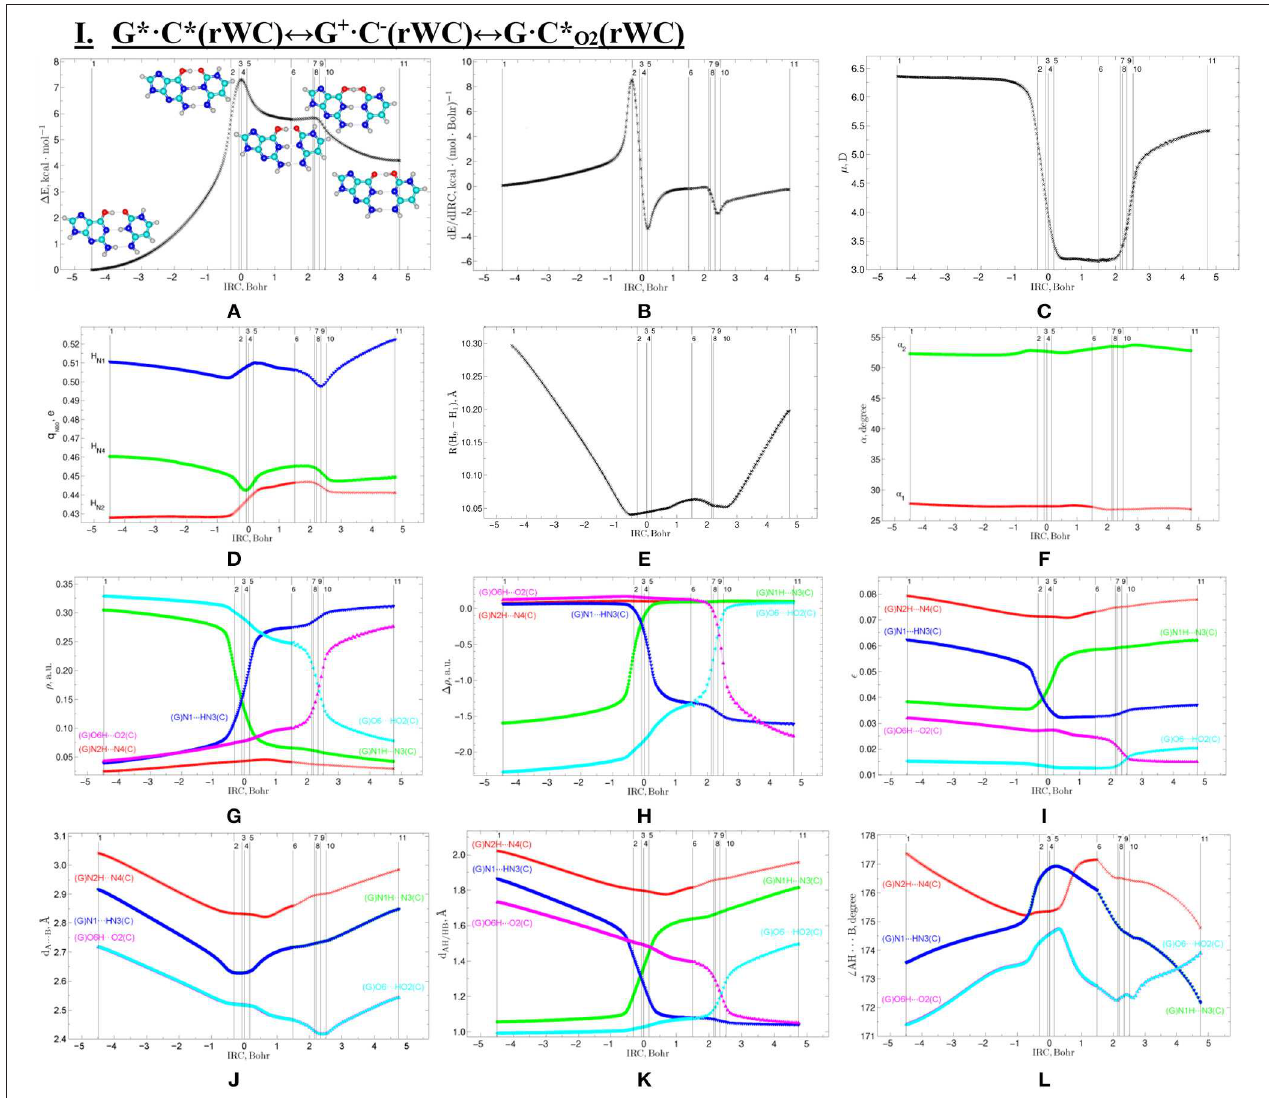
FIGURE 3 | Profiles of: (A) the relative electronic energy 1 E, (B) the first derivative of the electronic energy with respect to the IRC (dE/dIRC), (C) the dipole moment µ , (D) the NBO charges q NBO , (E) the distance R(H 1 -H 9 ) between the H 1 and H 9 glycosidic hydrogens, (F) the α 1 ( 6 N1H 1 (C)H 9 (G)) and α 2 ( 6 N9H 9 (G)H 1 (C)) glycosidic angles, (G) the electron density ρ ; (H) the Laplacian of the electron density 1 ρ , (I) the ellipticity ε at the (3, electronegative A and B atoms; (K) the distance d AH / HB between the hydrogen and electronegative A or B atoms and (L) the angle 6 AH hydrogen bonds along the IRC of the investigated I. G* B3LYP/6-311 G(d,p) level of theory in ++